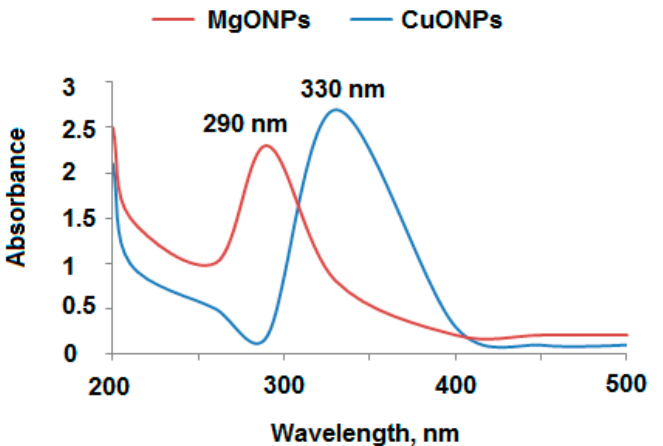
Figure 2. UV-Vis spectra of the synthesized MgONPs and CuONPs, the absorbance wavelength at 200–500 nm.